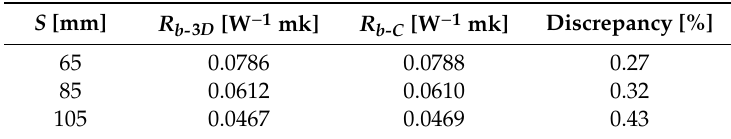
Table 4. Comparison of the borehole thermal resistance evaluated by numerical simulation and that determined through the analytical model [42].